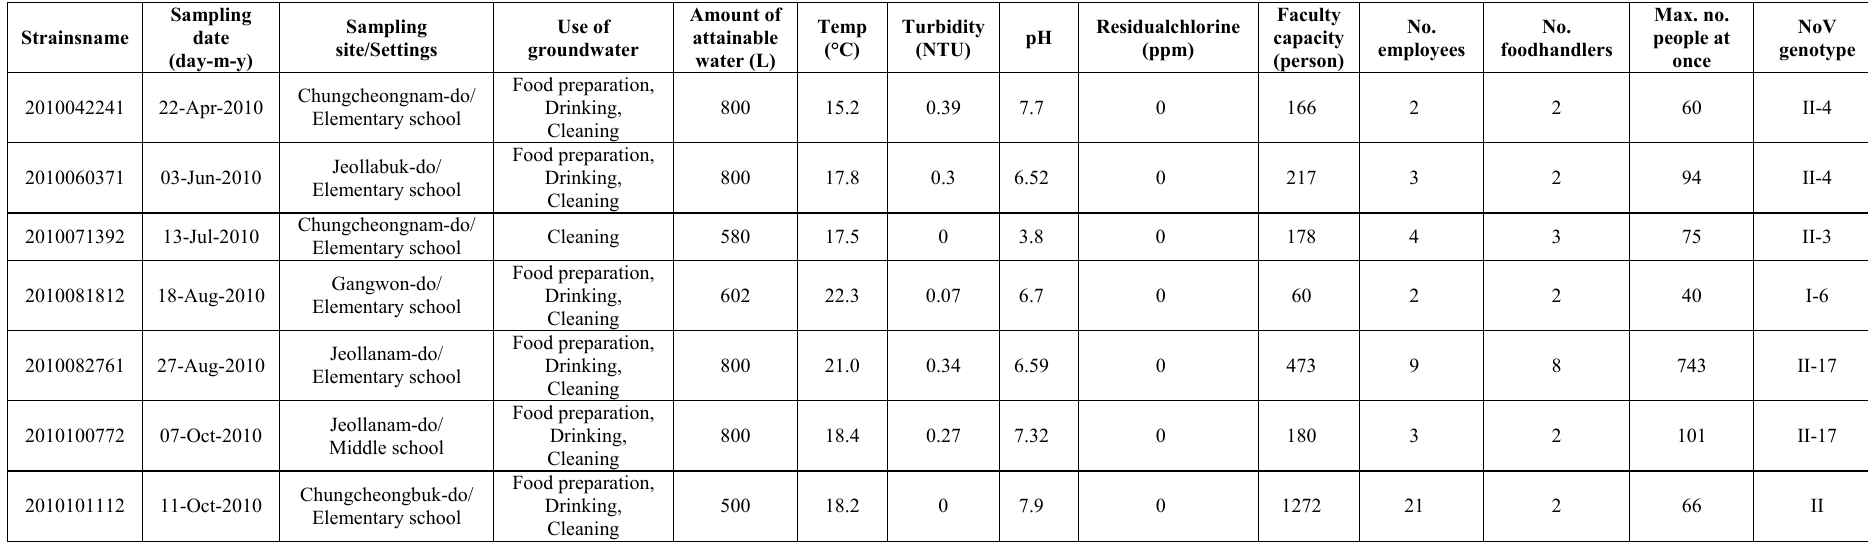
Table 2. Water quality (physical-chemical parameters) and microorganism data of NoV-contaminated